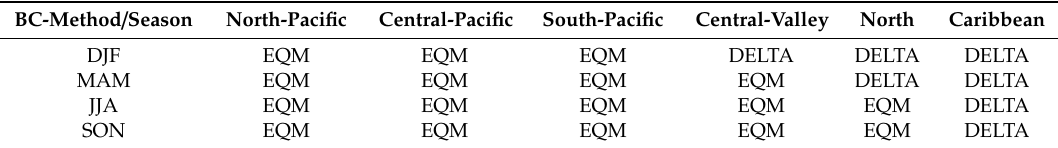
Table 2. Selection of bias correction methods applied to individual GCM-RCM pairs for future periods over all climatic regions of Costa Rica with respect to baseline